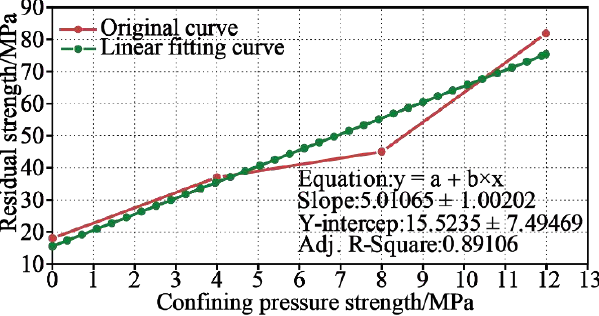
Figure 13. The relations between confining pressure strength and residual strength.